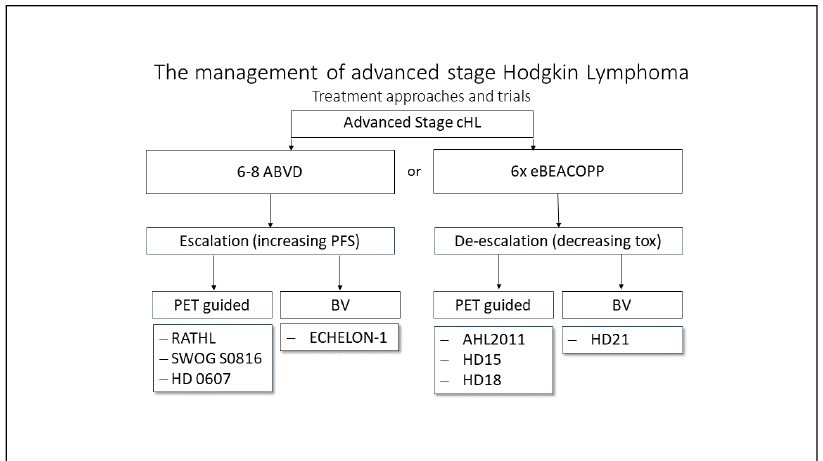
Figure 2. Treatment options overview for advanced classical Hodgkin lymphoma (cHL). The figure displays treatment approaches reviewed in clinical trials. Either escalating treatment to improve progression-free survival rates (PFS) by PET-guided switching to eBEACOPP or by addition of new drugs (BV) or de-escalation of efficient but toxic treatment approaches guided by PET/CT or including new targeted